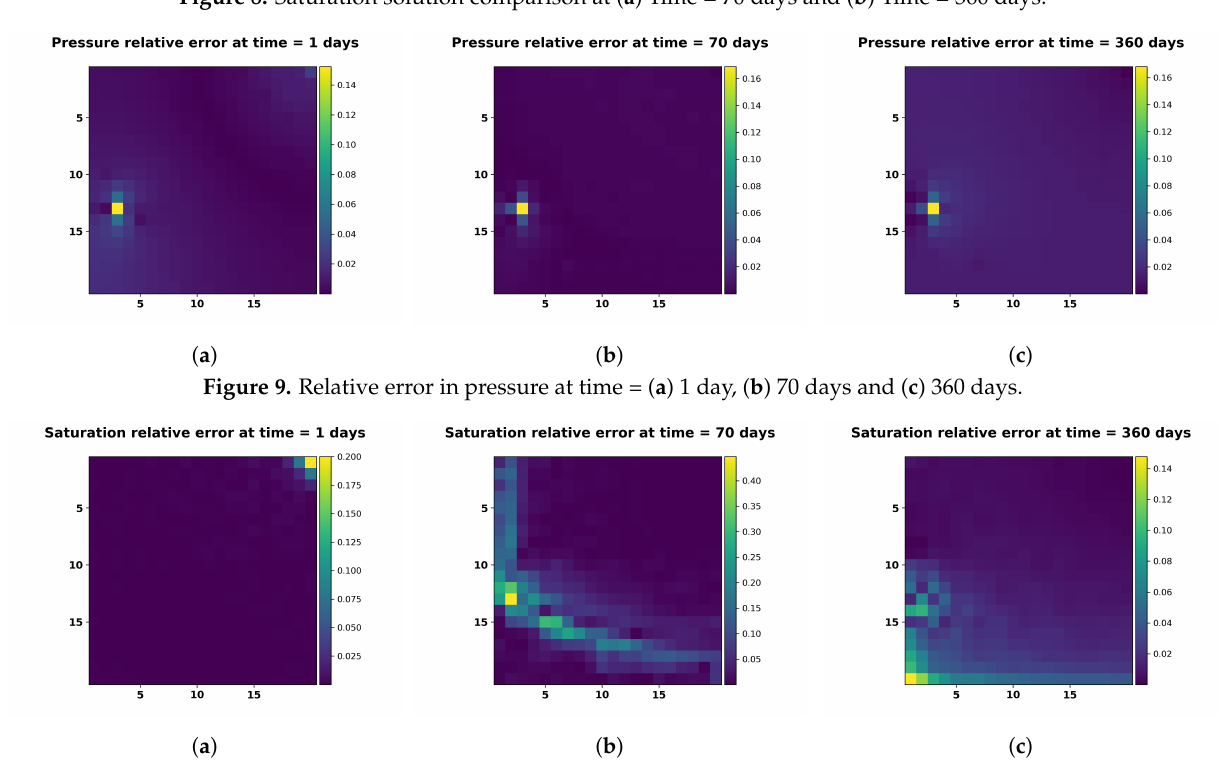
Figure 10. Relative error in saturation at time = ( a ) 1 day, ( b ) 70 days and ( c ) 360